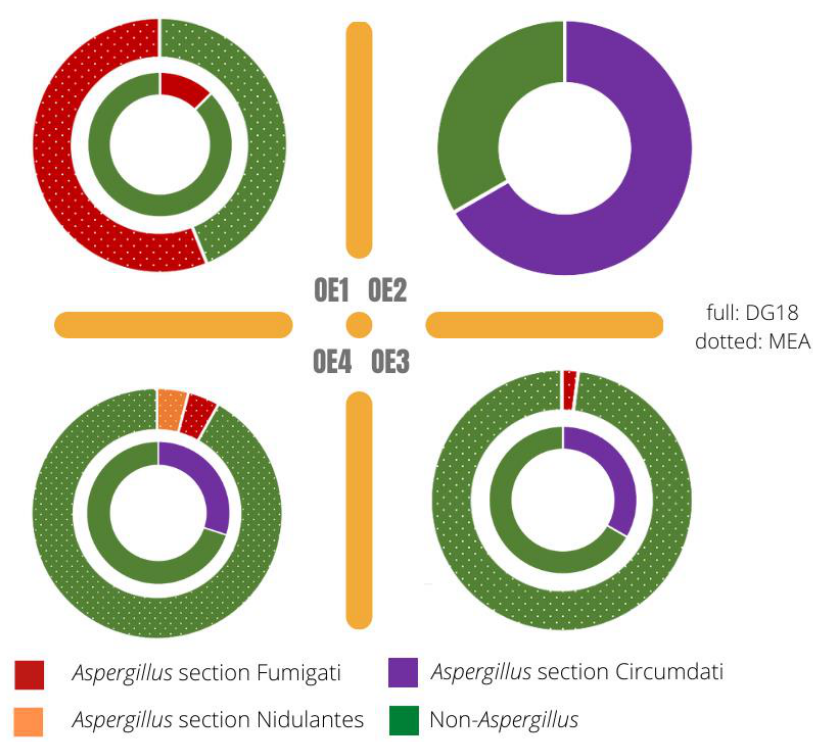
Figure 6. Aspergillus sections distribution by media and sampling place. Regarding species diversity on MEA, OE1 was the one with higher diversity (Shan- non index (H) = 1.514, Simpson index (D) = 3.408) (Table 2).